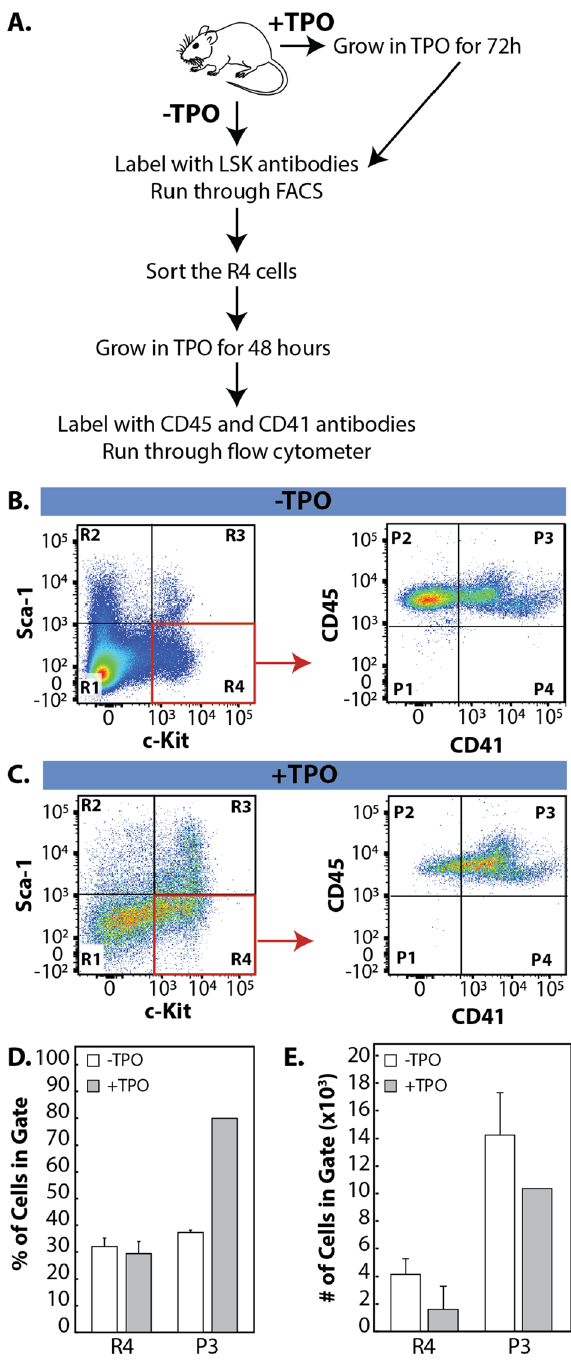
Figure 6. Identification of a repopulating MKRP cell population. ( A ) Overview of experimental design. Bone marrow cells were harvested and split into two populations: 1. − TPO cells were labeled with LSK antibodies, run on the FACS and the R4 subpopulation was sorted, then grown in TPO for 48 h before labeling with the MK cell markers, CD45 and CD41. 2. + TPO cells were grown in TPO for 72 h, labeled with LSK antibodies, run on the FACS, and the R4 subpopulation was sorted then regrown in TPO for an additional 48 h before staining with the MK cell markers CD45 and CD41. ( B ) Flow cytometry plot of − TPO cells stained with LSK antibodies. The defined subpopulations were identified (R1–R4). R4 cells were sorted (red box) and regrown in TPO for an additional 48 h, then stained for MK markers and run on the flow cytometer. New subpopulations were identified (P1–P4) by the expression of MK surface markers. ( C ) Flow cytometry plot of + TPO cells stained with LSK antibodies to identify the defined subpopulations (R1–R4). R4 cells were sorted (red box) and regrown in TPO for an additional 48 h then stained for MK markers and run on the flow cytometer. New subpopulations were identified (P1–P4) by the expression of MK surface markers. ( D ) Percentage of cells in the R4 (MKRP cells) and P3 (MKs) gates. ( E ) Number of cells in the R4 (MKRP cells) and P4 (MKs) gate. For ( D ) and ( E ) error bars represent the standard deviation of the mean from three independent bone marrow harvests from